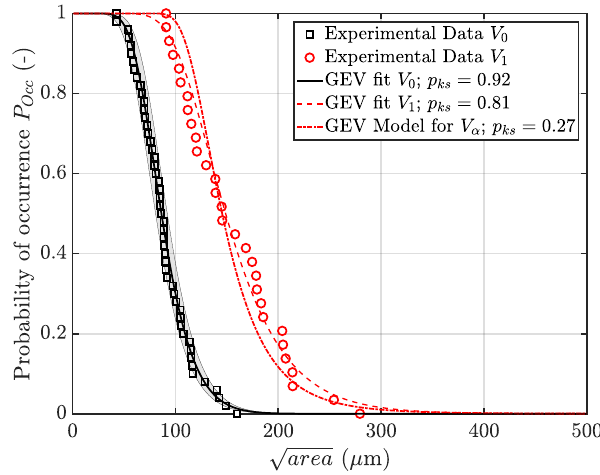
Figure 11. Probability of occurrence of critical defect sizes in specimen geometry A and